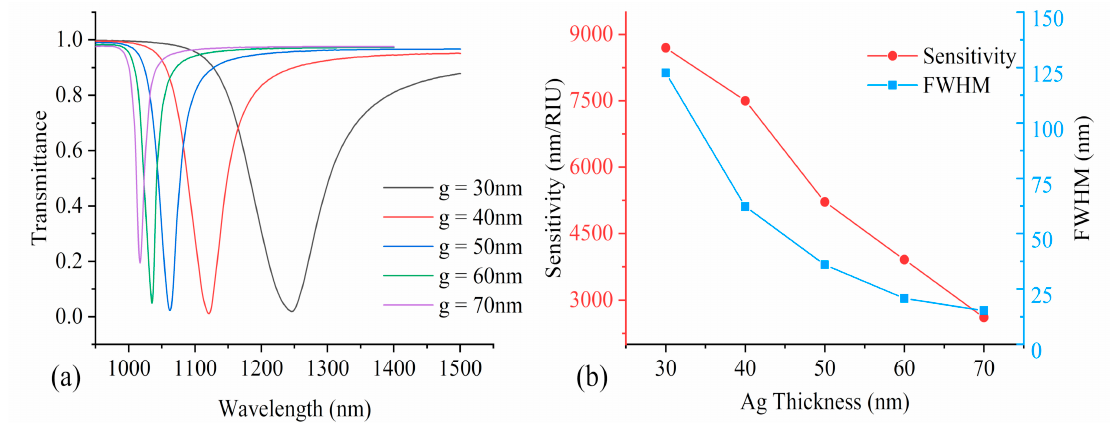
Figure 5. ( a ) The resonance spectra of the proposed sensor with the variation of the Ag layer thickness g . ( b ) The full-width at half-maximum (FWHM) and sensitivity of the sensor under the di ff erent values of g . The figure of merit (FOM) values along with the increases of g : 70.9, 120.6, 144.9, 188.8, and 170.7.